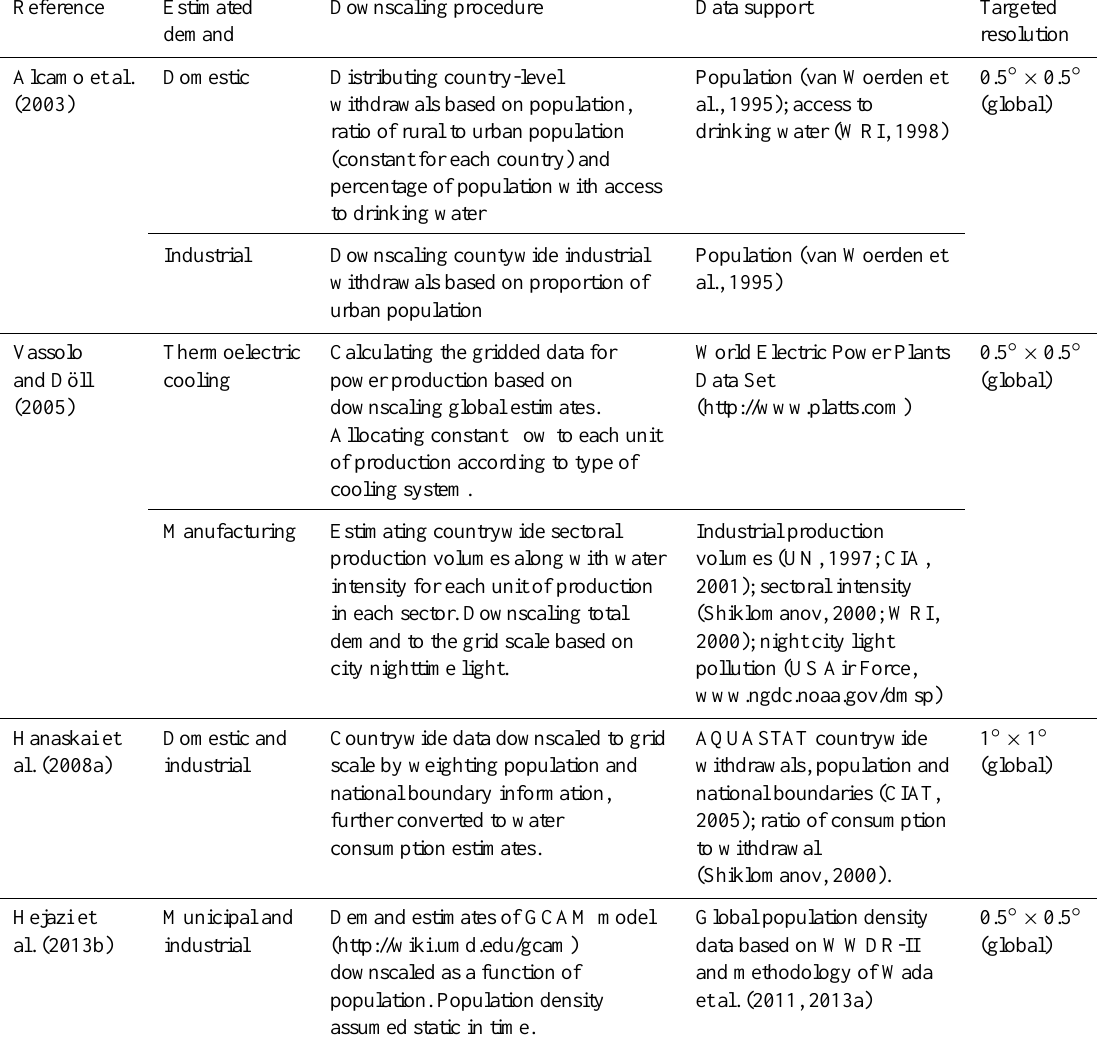
Table 4. Representative examples calculating grid-based non-irrigative demands using downscaling of coarse-scale estimates.